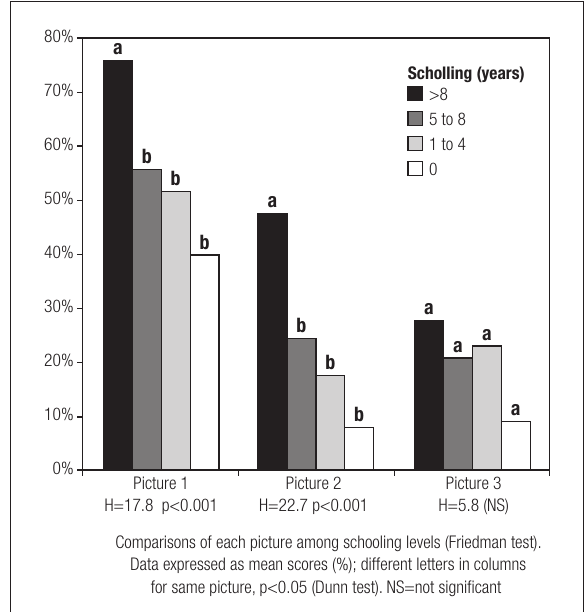
Figure 2. Visual reproduction by individuals, aged 60-92 years, with differ- ent schooling levels according to picture complexity.